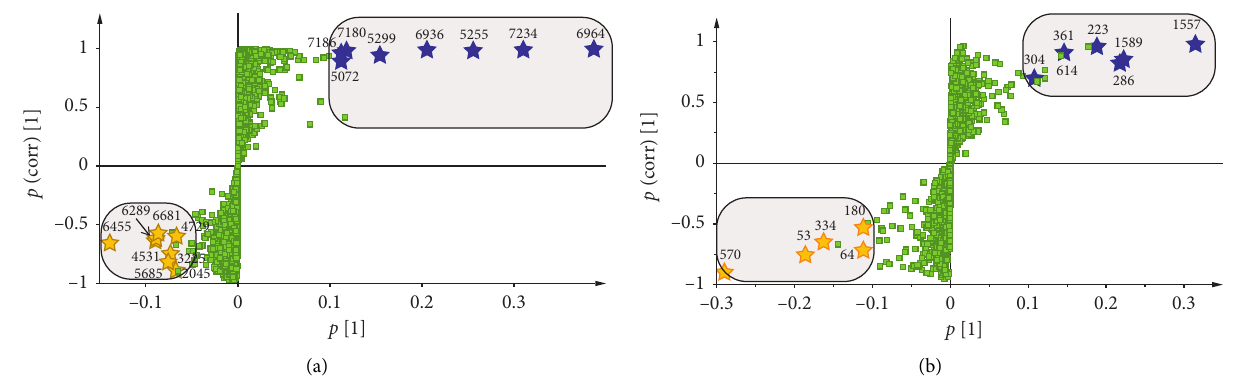
Figure 6: S-plot at the first component used in potential distinguished components selection based on LC-Q/Tof-MS (a) and GC-MS (b), constituent ions with VIP value > 4 were marked with a black square, compounds marked with yellow stars are richer in CNA, and dark blue marked compounds are richer in OA.